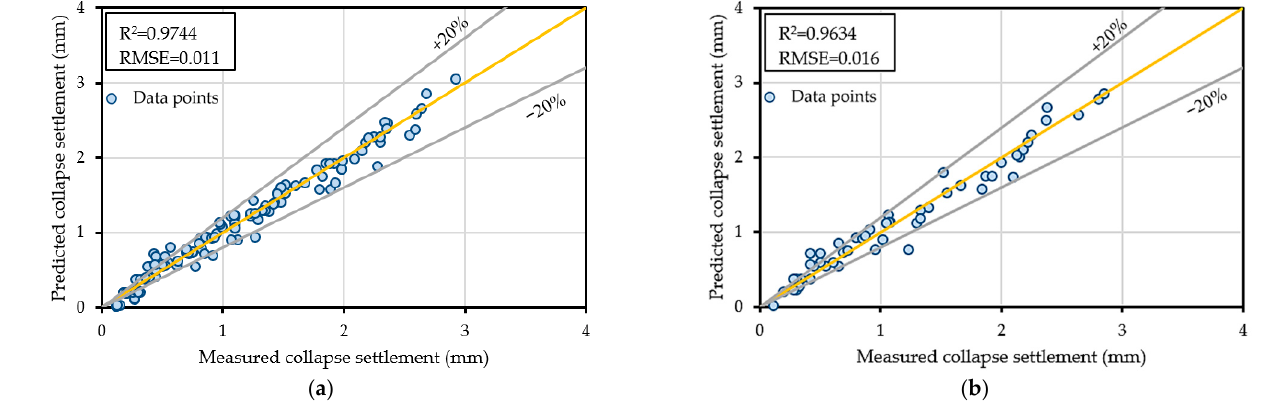
Figure 5. Comparing the results of the predicted and measured collapse settlement based on the tangent hyperbolic function. ( a ) Training data, ( b ) Testing data.